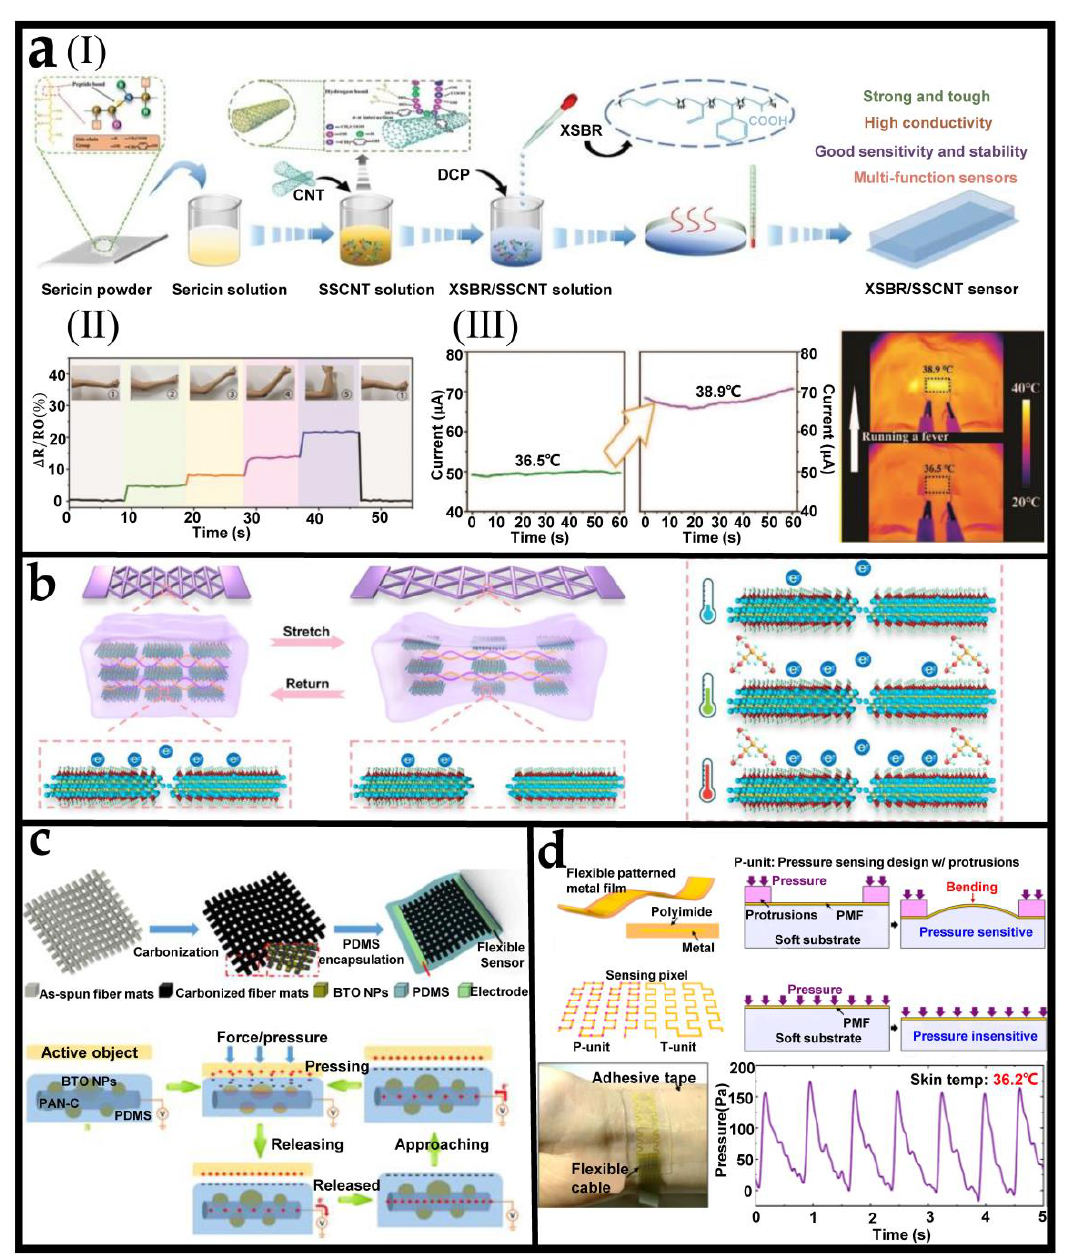
Figure 2. Single sensors with multiple functions. ( a ) ( Ⅰ ) The preparation of flexible XSBR/SSCNT sensors. ( Ⅱ ) Bending of the elbow and corresponding signals. ( Ⅲ ) Measurement of human forehead temperature before and after “artificial fever” with XSBR/SSCNT sensors. Reprinted with permission from [88] . Copyright 2022 Wiley-VCH. ( b ) Strain and temperature sensing mechanisms of the printed conductive hydrogel. Reprinted with permission from [89] . Copyright 2022 Nature Publishing Group. ( c ) The fabrication process and working mechanism of the flexible dual-function PAN-C/BTO self-powered pressure sensor. Reprinted with permission from [90] . Copyright 2018 American Chemical Society. ( d ) The sensing mechanism and applications of the e-skin prototype. Reprinted with permission from [91] .